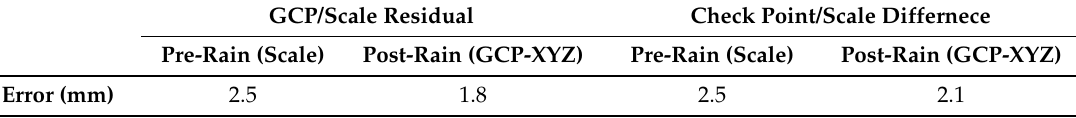
Table 4. Performance of 3D reconstruction assessed with root mean square RMS of the residuals at the GCPs and scales and accuracy of the reconstructed point cloud assessed with RMS of the residuals at the check points and scales. GCP/Scale Residual Check Point/Scale Differnece Pre-Rain (Scale) Post-Rain (GCP-XYZ) Pre-Rain (Scale) Post-Rain (GCP-XYZ) Error (mm)